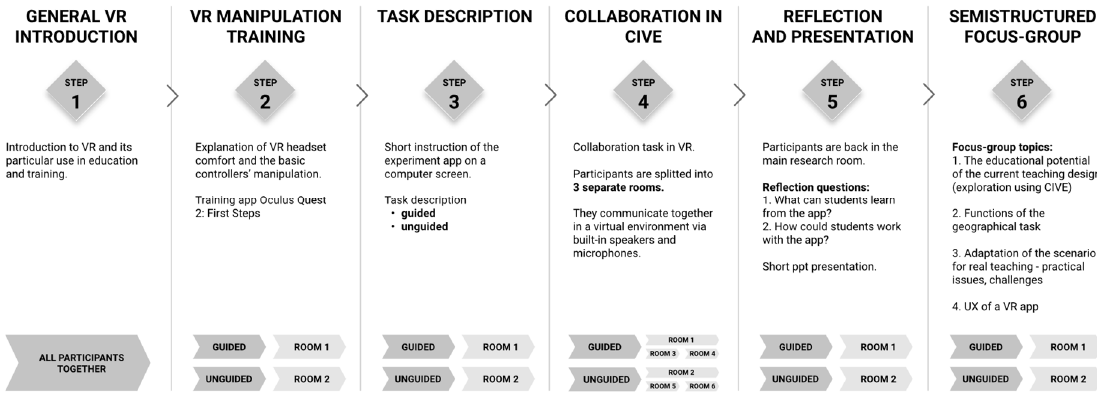
Figure 3. Research procedure.